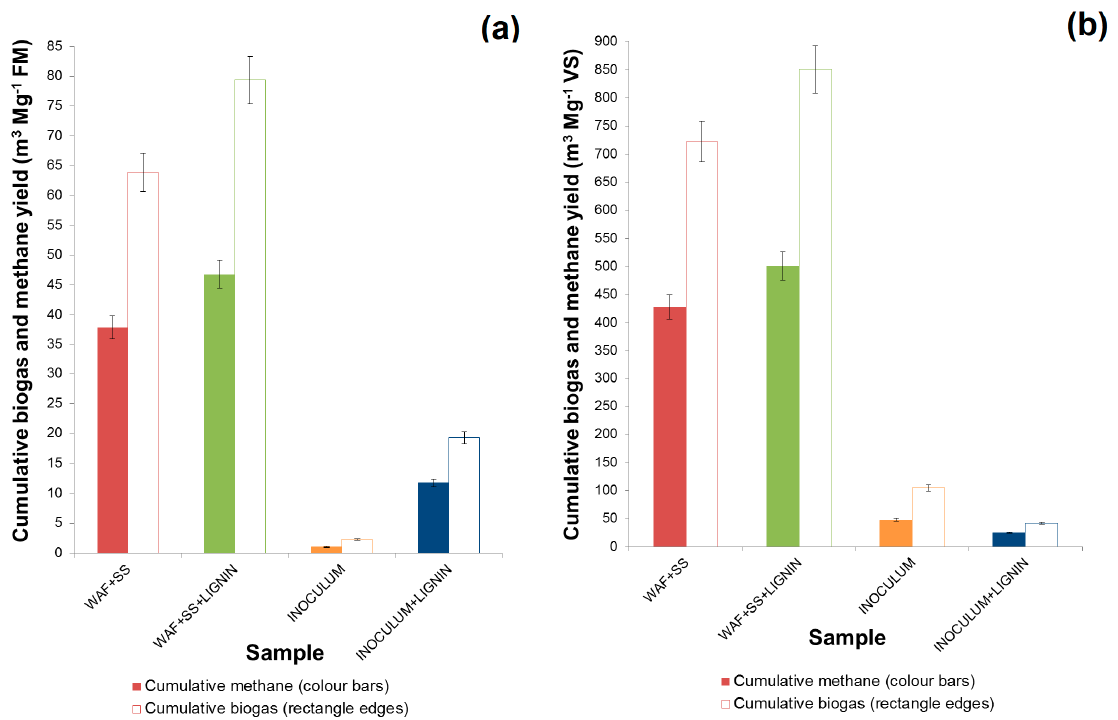
Figure 13. Cumulative biogas and methane yield from the fresh matter (FM) ( a ) and volatile solids (VS) ( b ) of the WAF + SS, WAF + SS + Lignin, Inoculum, Inoculum + Lignin samples. Lalov et